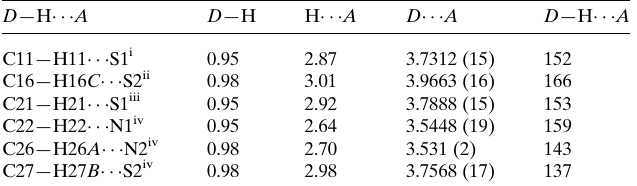
Table 2 Selected geometric parameters (A˚ , (cid:4) ) for form II.